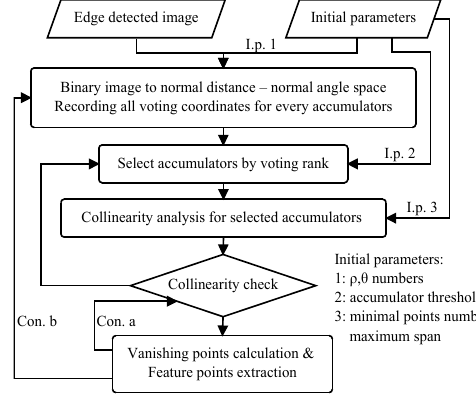
Figure 2. Procedure for feature line